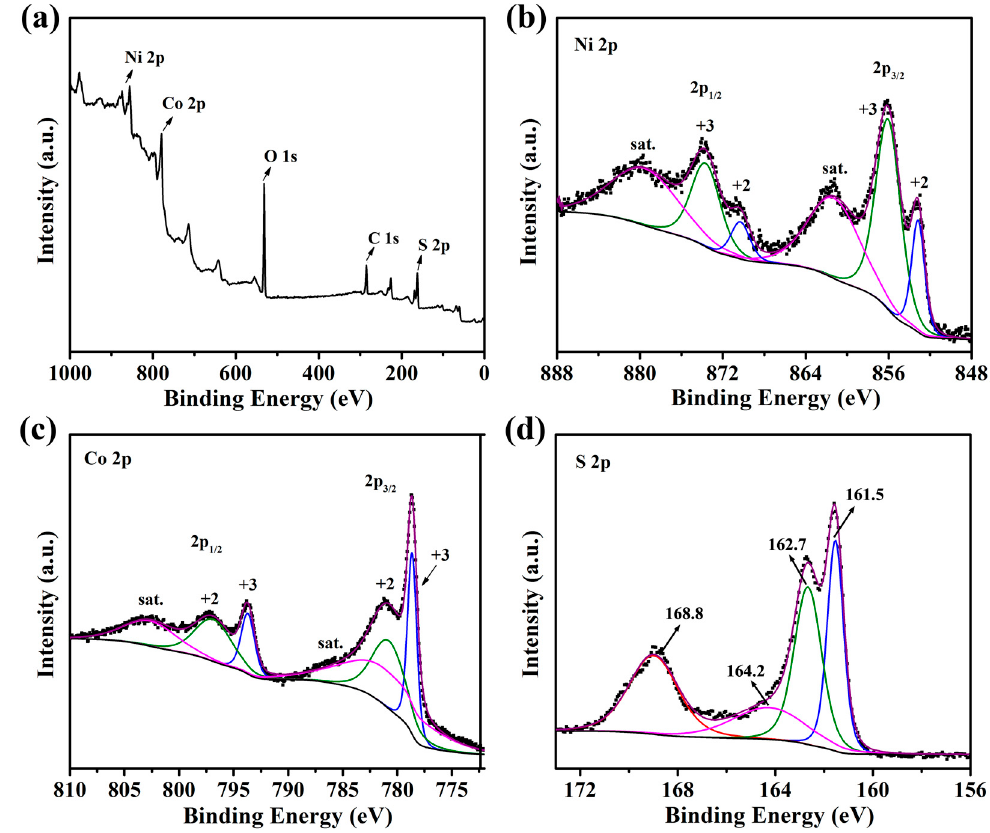
Figure 4. ( a ) XPS survey spectra; ( b ) Ni 2p; ( c ) Co 2p; and ( d ) S 2p high ‐ resolution spectra